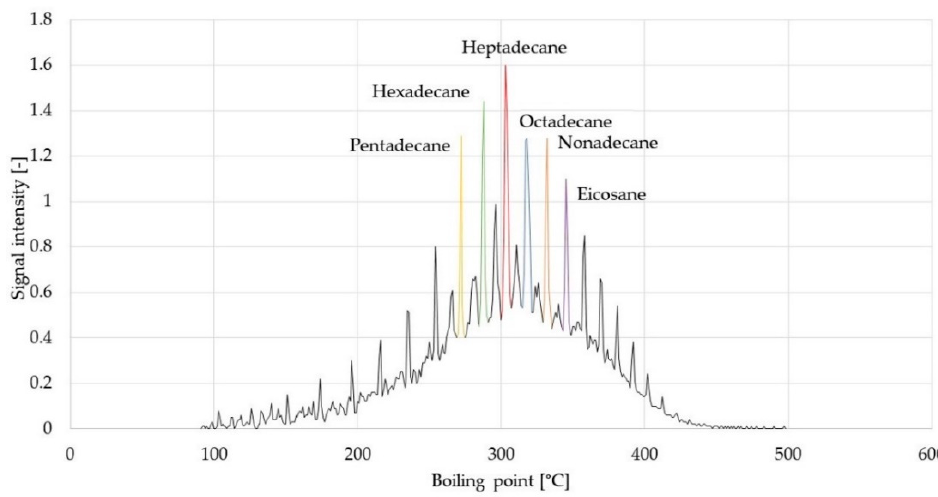
Figure 16. Selected alkanes in average sample after deactivation (blank test).